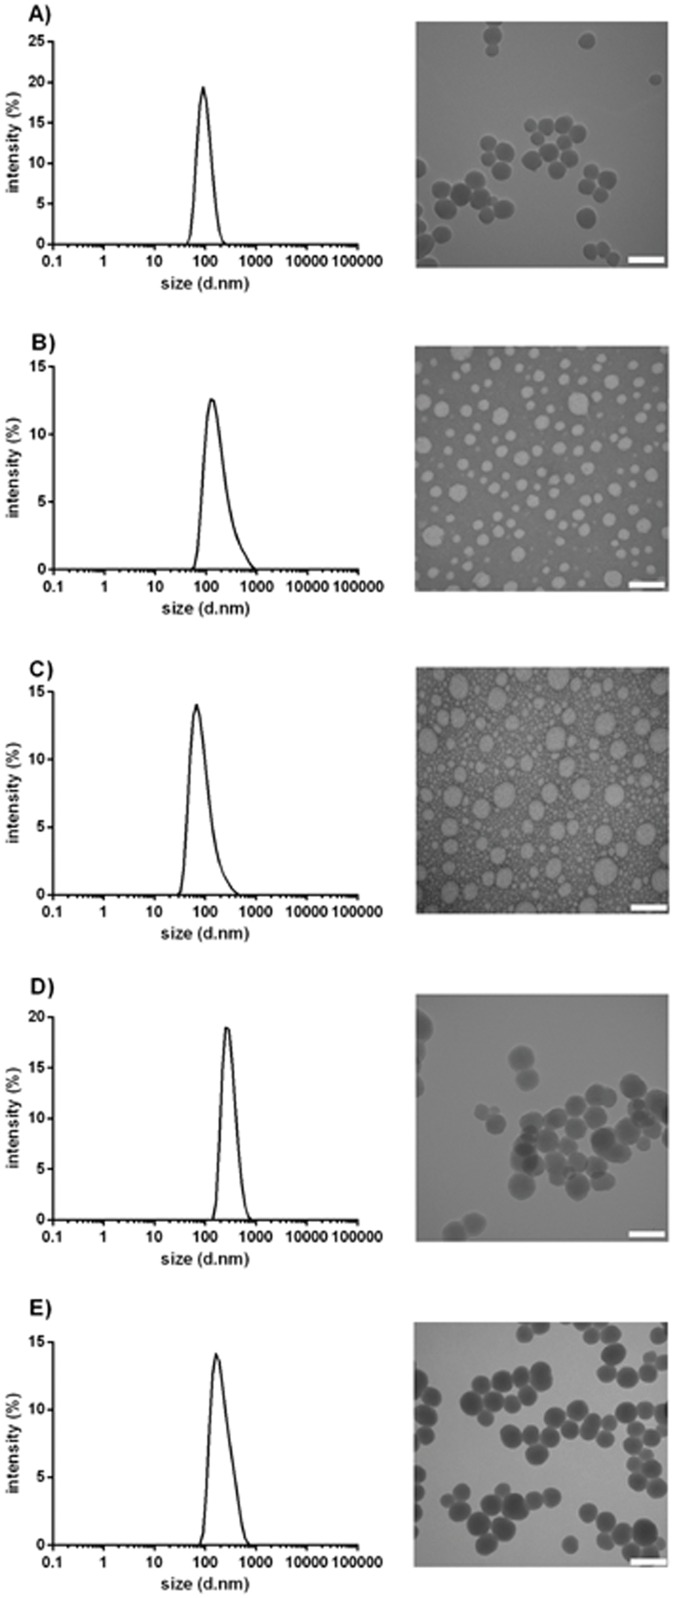
TEM images of nanoparticles A) silica, B) PLGA, C) PCL, D) amine functionalized silica and E) pegylated silica.Scale bar is 100 nm.